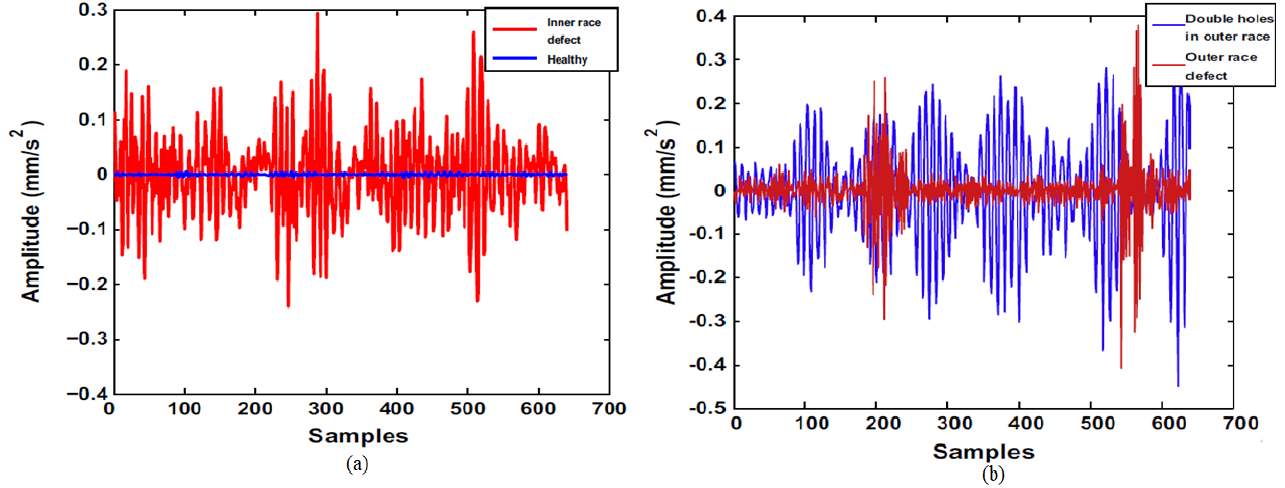
Figure 13. RNFC filter results for the diagnosis of ( a ) healthy and inner race defects and ( b ) outer race defects and double holes in outer race defects [36].